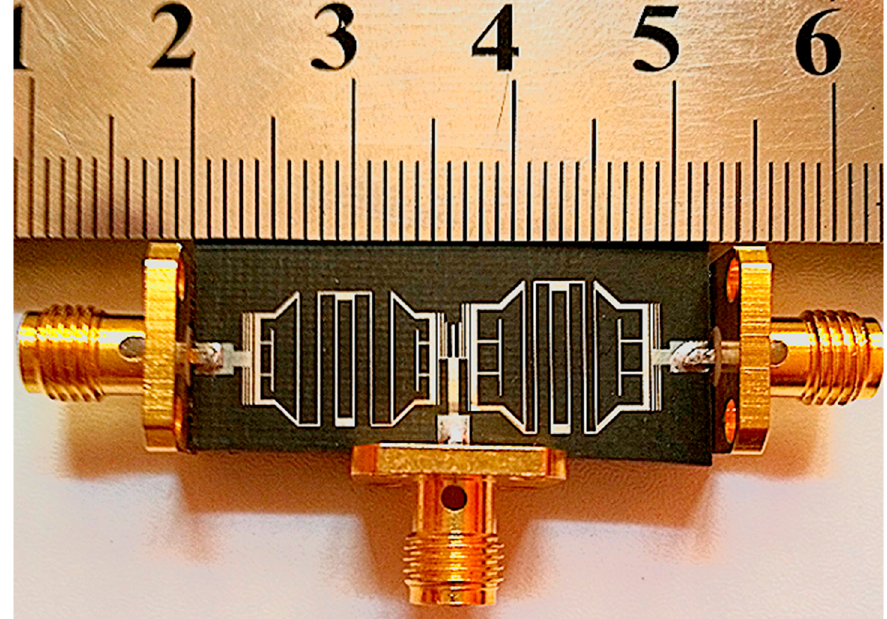
Figure 13. Fabricated photo of the proposed diplexer.